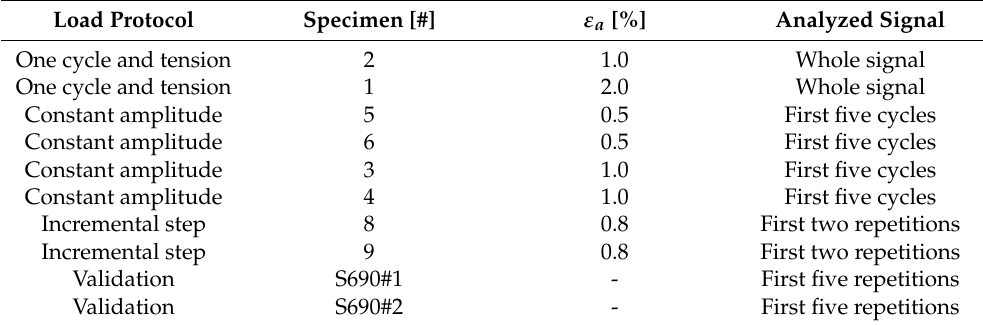
Table 3. Overview of the material parameter estimation experiments and the validation experiments. Each load protocol is fully reversed. The strain amplitude ε a is given in percent